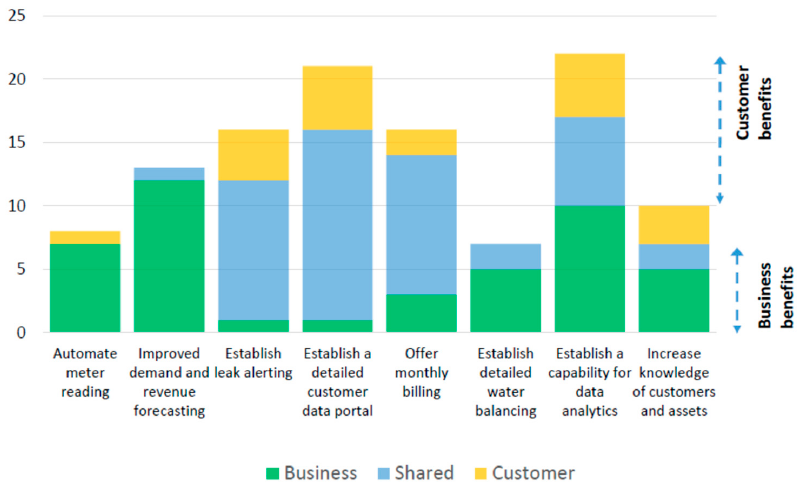
Figure 3. The number of benefits that each change impacts 1 . ( 1 Enabler#1 (Automate meter reading using AMI) impacts all seventy-five benefits. Only the eight benefits where it is the only enabler required are shown.).